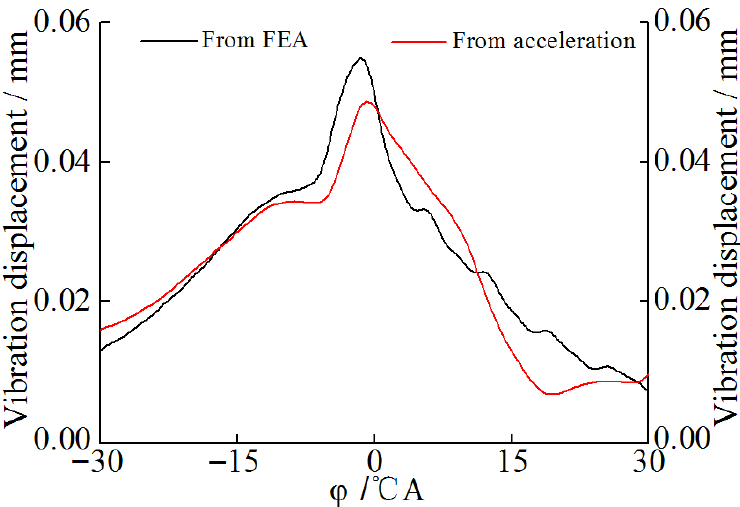
Figure 6. Comparison of the vibration displacement.